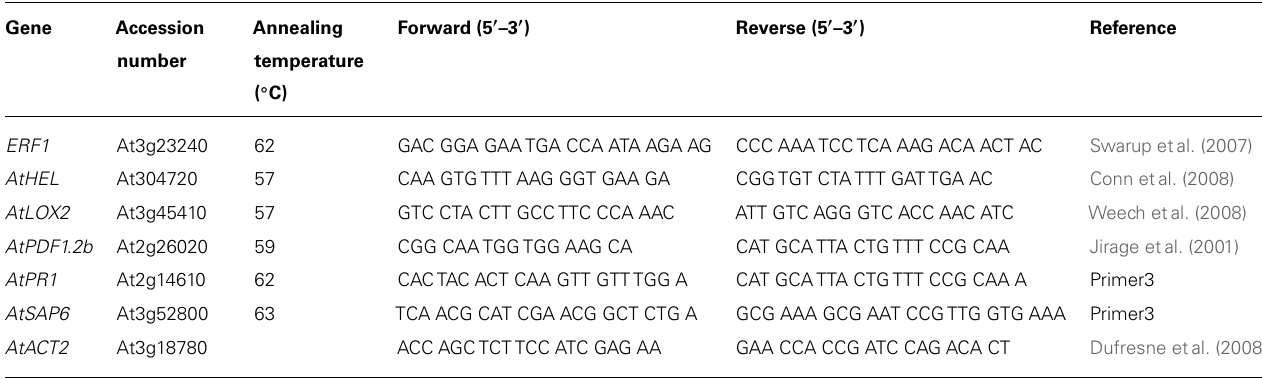
TableA1 | Quantitative real-time polymerase chain reaction primers.